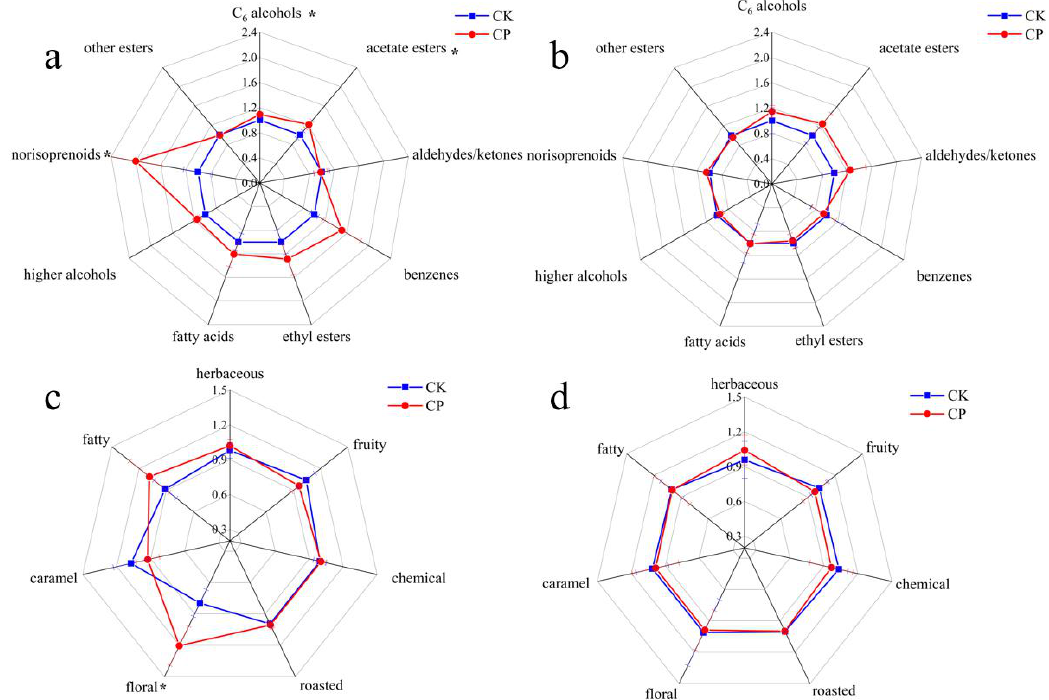
Figure 9. Influence of covering purslane on the aroma profiles and odor activity values (OAVs) in their wines. ( a ) aroma profiles in wines of the year 2018, ( b ) aroma profiles in wines of the year 2019; ( c ) OAVs of main aroma compounds (OAV > 0.1) in the year 2018; ( d ) OAVs of main aroma compounds (OAV > 0.1) in the year of 2019. * indicates significant differences between the wines of the control and covering purslane ( p < 0.05, t -test).